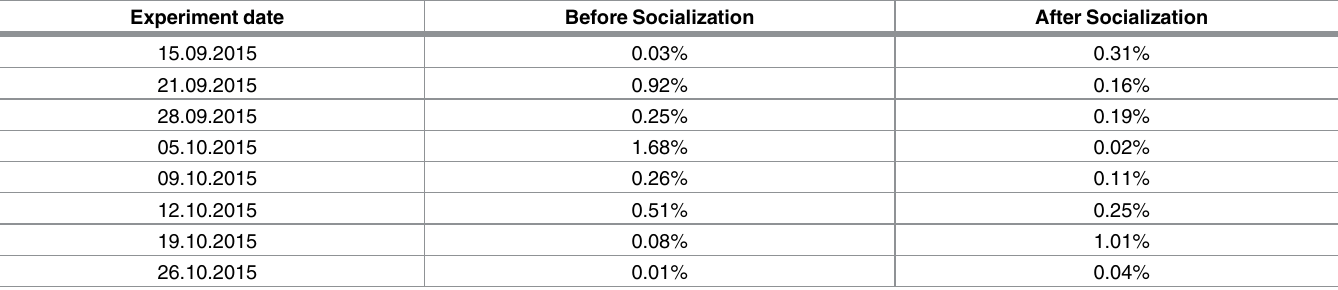
Table 8. The deviation of the winning from the theoretical equilibria to the experimental data before and after Socialization.